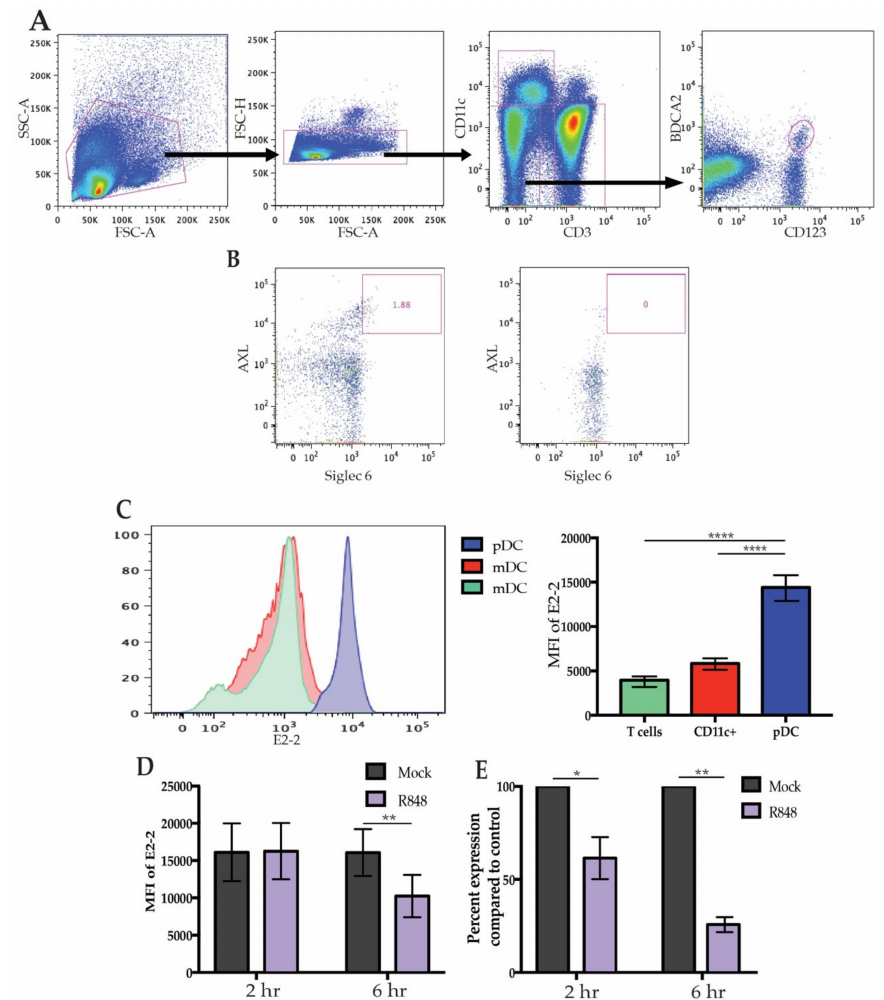
Figure 1. E2-2 expression in plasmacytoid dendritic cells (pDCs). ( A ) Gating strategy to identify pDCs from human peripheral blood mononuclear cells ( PBMCs). ( B ) Gating to determine removal of AXL + Siglec 6 + DCs after negative selection for pDCs. ( C ) E2-2 expression in CD3 + and CD11c + cells compared to pDCs as determine by flow cytometry. Representative histogram on the left, quantified mean fluorescent intensity (MFI) on the right. n = 11 independent experiments. ( D ) PBMCs were stimulated with 10 µ M R848 for up to 6 h and E2-2 expression was measured via flow cytometry. n = 8 independent experiments. ( E ) mRNA expression from PBMCs measured by qRT-PCR after 6 h R848 stimulation. n = 3 independent experiments. Data are presented as means ± SEM. p values < 0.05 were considered significant. * p < 0.05, ** p < 0.01, *** p < 0.001, **** p <